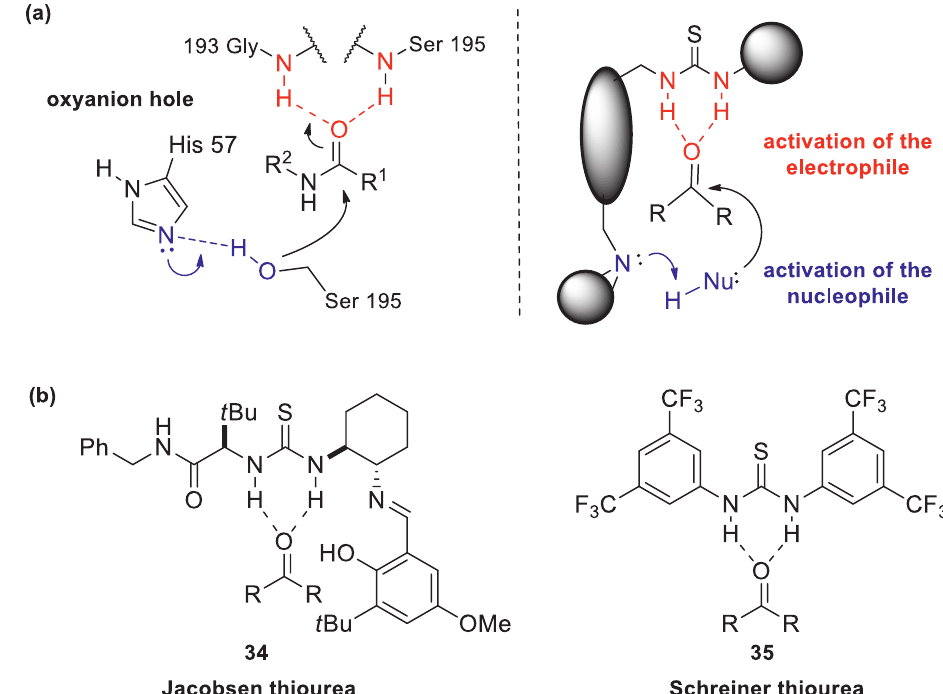
Figure 11 . (a) The so-called “ oxyanion hole ” in serine protease activating a carbonyl; (b) H-bonding organocatalysts activating a